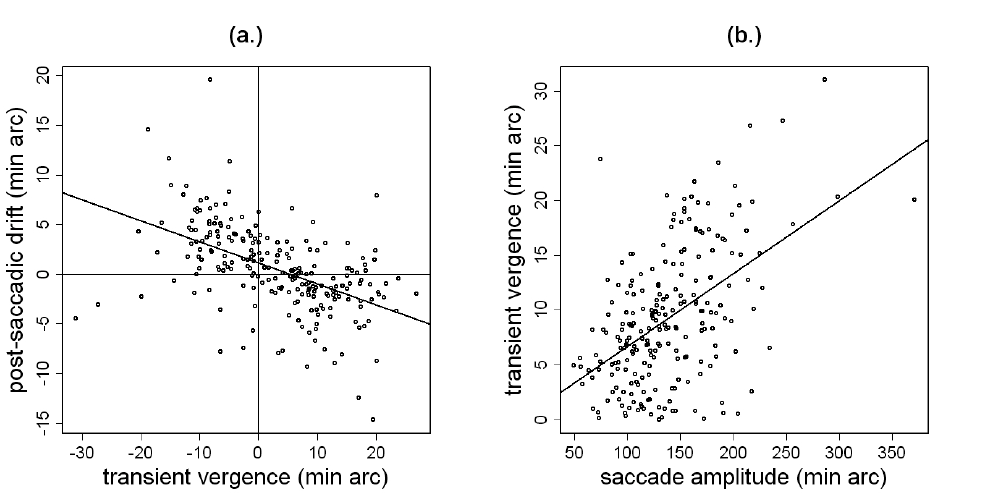
Figure 1: (a) shows the change in post-saccadic drift (min arc) as a function of transient vergence (min arc); in (b) the changes of absolute transient vergence (min arc) as a function of saccade amplitude (min arc) are shown. Lines represent the linear trend within the